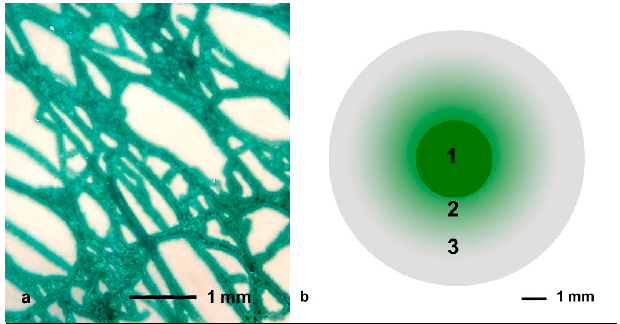
Figure 8. SFF mat directly embedded in chalcedony: ( a ) Micrograph in transmitted light. ( b ) Schematic cross section of an SFF: 1 = core SFF, 2 = chalcedony with inclusions of clay minerals, and 3 = pure SiO 2 . The second group was characterized by SFF (Figure 9a,b) with three different major zones: (a) central SFF, (b) surrounding zone of an empty tube, occasionally with fibrous mordenite, and (c) an external zone consisting of a thick SiO 2 layer (0.5 to 20 mm) and occasionally embedded mordenite. The central SFF consisted of an innermost core SFF with diameters between 5 and 50 μ m and a surrounding zone of different clay minerals. The color varied between intense green, olive ‐ green, and brown to nearly black. The surface texture was characterized by joint spherical aggregates with a common uniform surface. If mordenite was precipitated between the central SFF and the SiO 2 crust, the surface of the central SFF was partly covered by adherent fibrous mordenite crystals. SFFs of the second group formed predominantly linear to curved fabrics. The cross ‐ section of the core SFF showed a radiating arrangement of curved, flake ‐ like minerals without any characteristic crystal shape, even at high magnification.